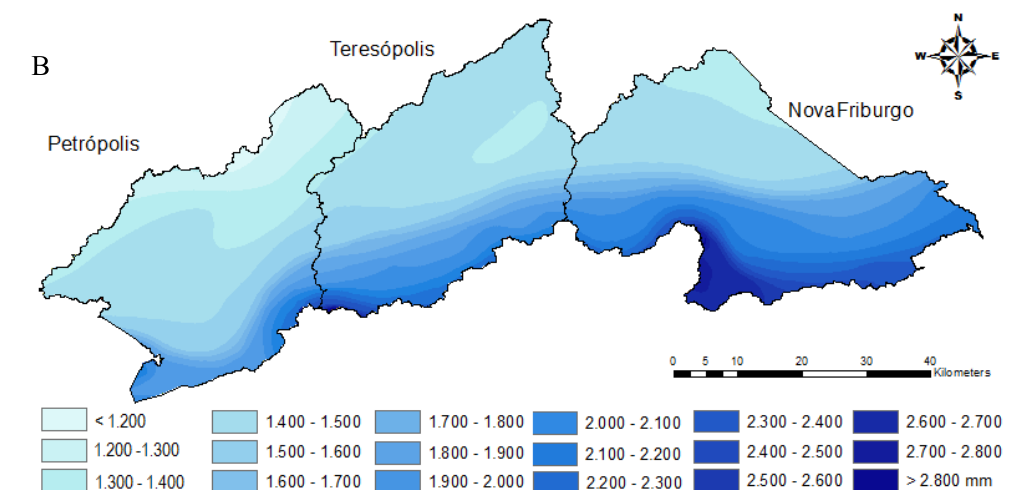
Figure 3. ( A ) Average monthly rainfall (from 2008 to 2018) for the studied municipalities. ( B ) Average annual rainfall from 1997 to 2006. Source: http://www.cprm.gov.br/publique/Hidrologia/Mapas-e-Publicacoes/Atlas-Pluviometrico-do-Brasil- 1351.html.